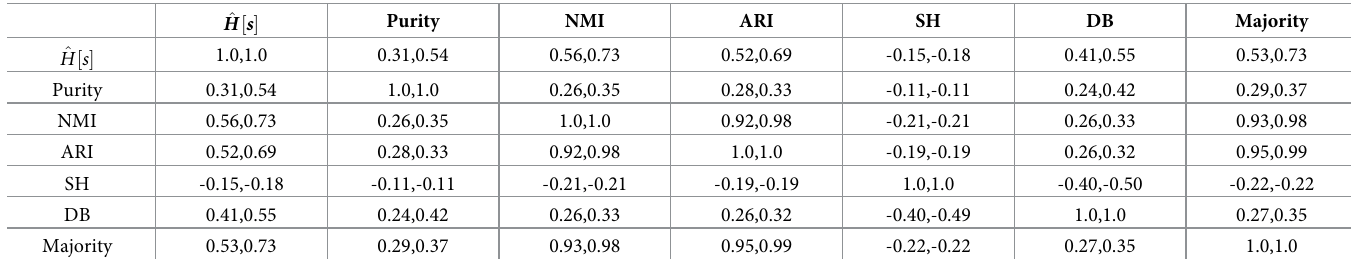
Table 8. Kendall’s τ and Spearman’s correlation result for White Wine.